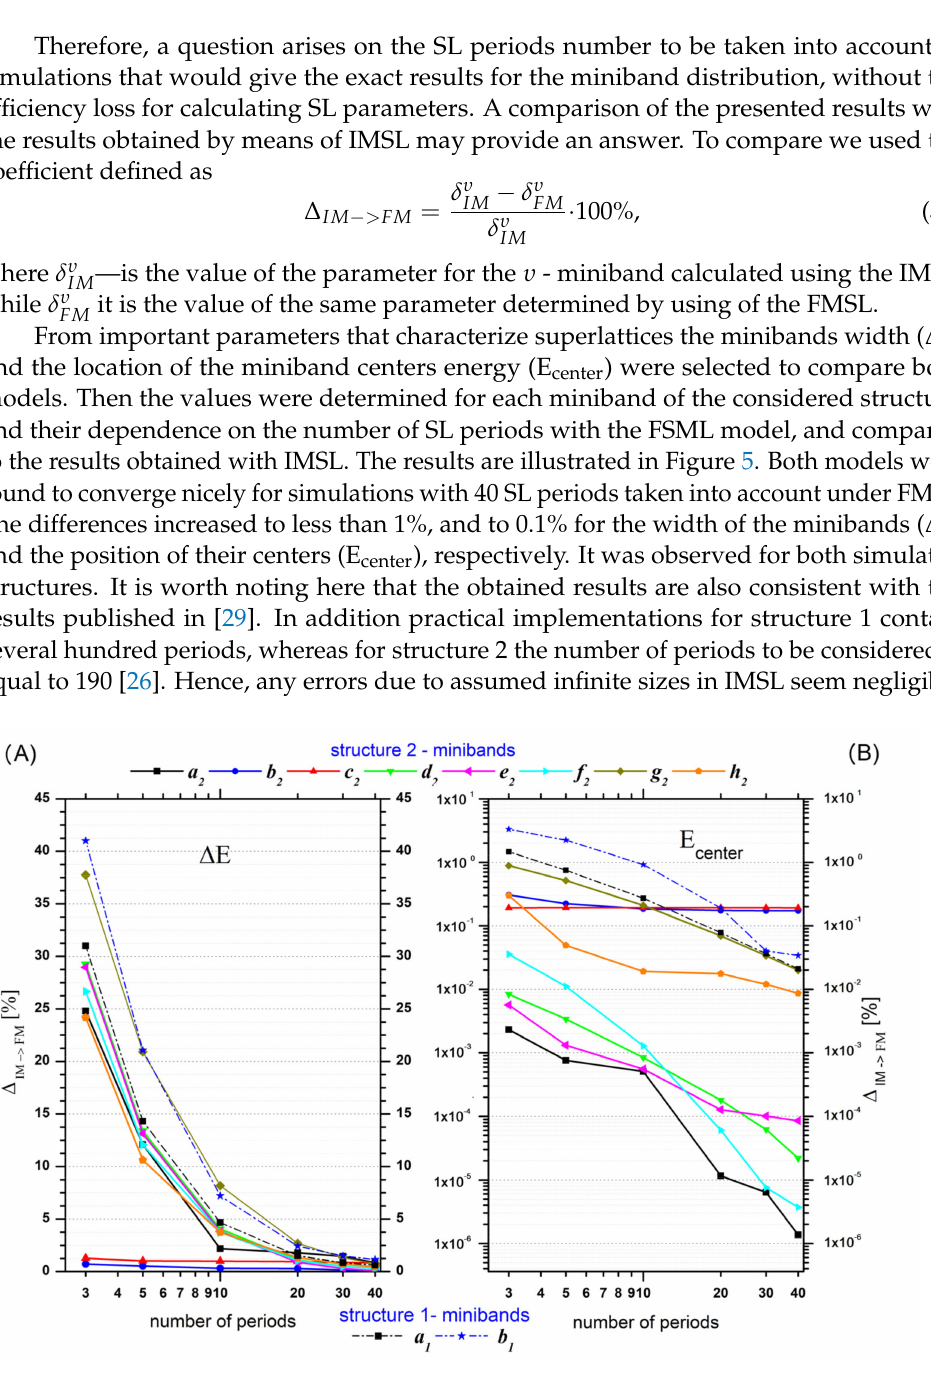
Figure 5. The convergence for IMSL and FMSL illustrated by exemplary minibands simulation for two typical SL structures. The dashed line corresponds to the results for structure 1, while the dependencies concerned with structure 2 are plotted with solid ones. Part ( A , B ) show the convergence of the width of minibands ( ∆ E), and the energy positions at the centers of these minibands (E center ),